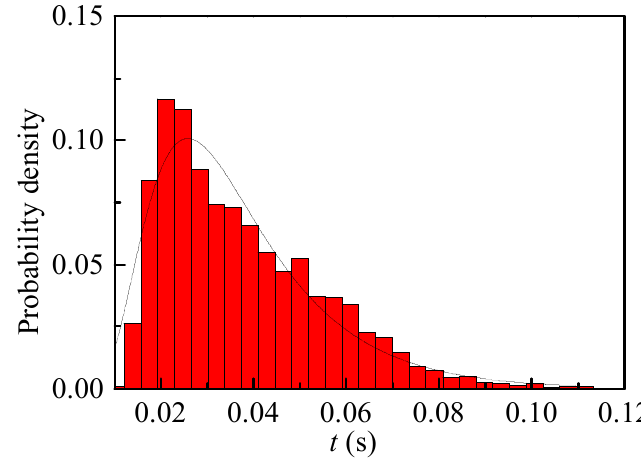
Figure 9. Motion trajectories of sediment particles. The circles indicate the collision position of sediment particles.